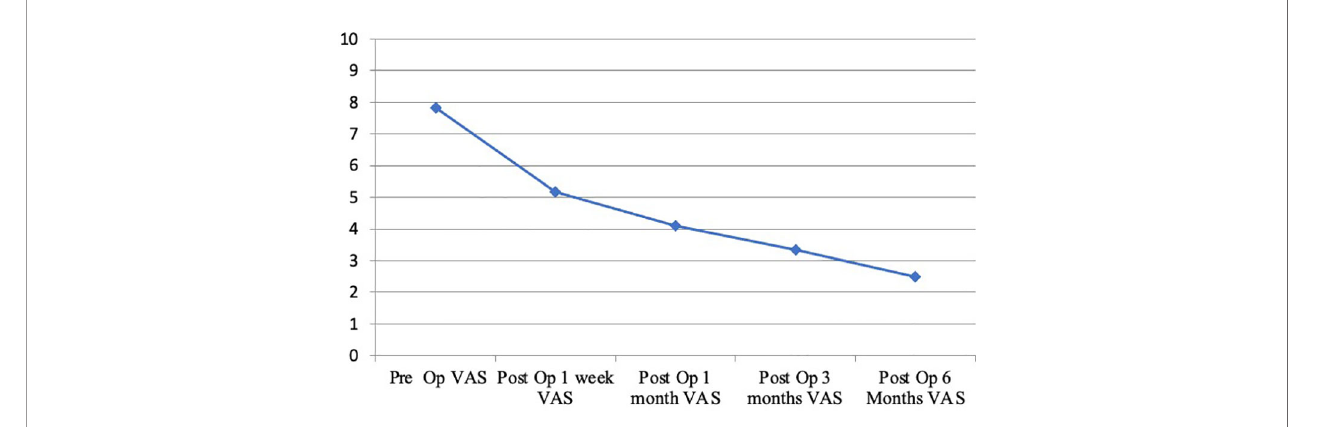
FIGURE 3 | Trend of the visual analogue scale (VAS, 0 to 10 ranged) in patients with back pain during a six month follow-up.